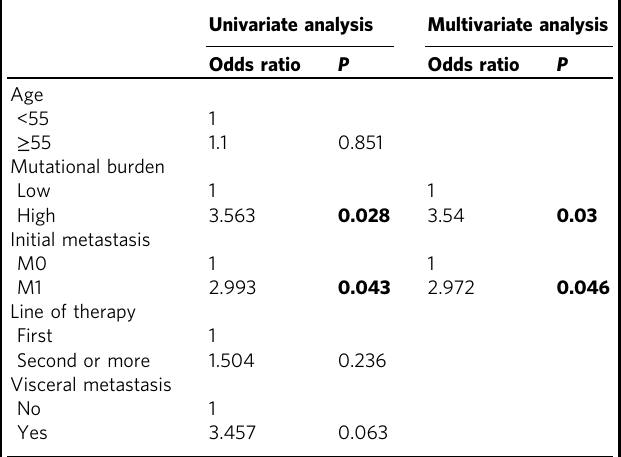
Table 2 Univariate and multivariate analyses of parameters associated with progression.